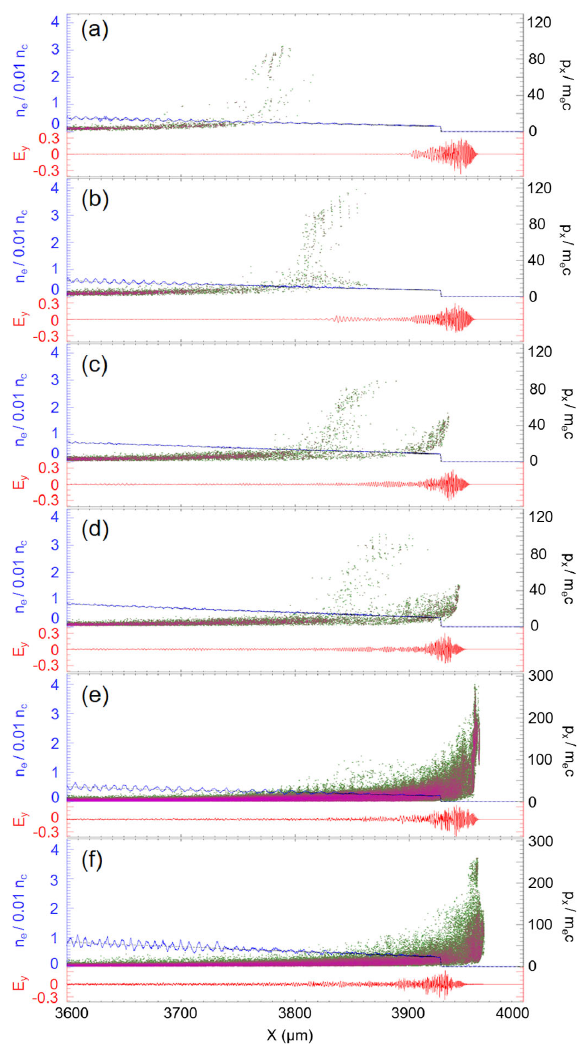
FIG. 3. Particle-in-cell simulations for the pure He case. (a – d) are the simulation results with a lower laser intensity of a 0 ¼ 0 . 57 at plasma densities of f 2 . 1 ; 2 . 4 ; 3 . 0 ; 3 . 5 g × 10 19 cm − 3 , respec- tively. The red plots denote the transverse electric field E y ω normalized to m 0 c=e , where m e is the electron mass and e ω 0 is the laser frequency. The blue curves denote the electron density profiles in units of 0.01 n which were originally set to be c the same as in the experiment, where n is the critical density for a c 800 nm laser. The electron ( x , p ) phase spaces are plotted out in x > m c are green (less) – violet (more). Only electrons having p x e drawn. (e, f) are the simulation results with a higher laser intensity of a 0 ¼ 1 . 13 at plasma densities of f 2 . 1 ; 3 . 5 g × 10 19 cm − 3 ,